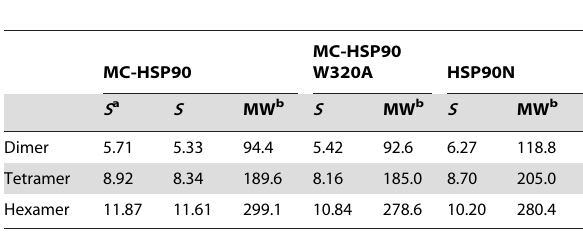
Table 2. Sedimentation coefficient results and molecule